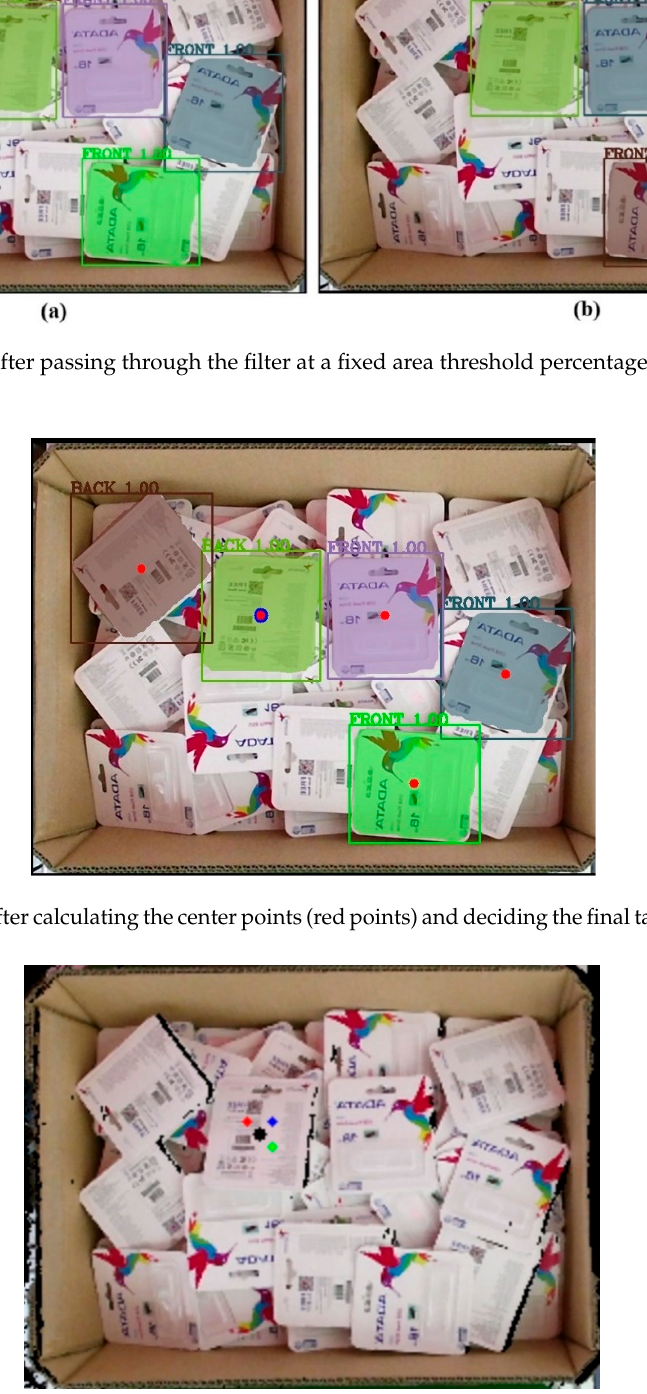
Figure 26. Result of mapping from a point in the color image to a point that had the same relative position in the depth image.